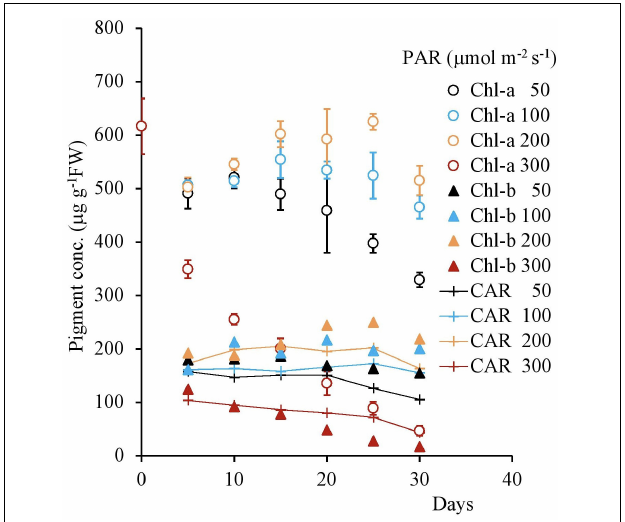
FIGURE 8 | The relations between H 2 O 2 , CAT, POD, and APX concentrations of plant tissues after 7 days experiment as a function of Fe concentration in water and PAR intensities. The round arrow indicates the variational trend with increasing Fe concentration. Vertical bars indicate the standard deviation.